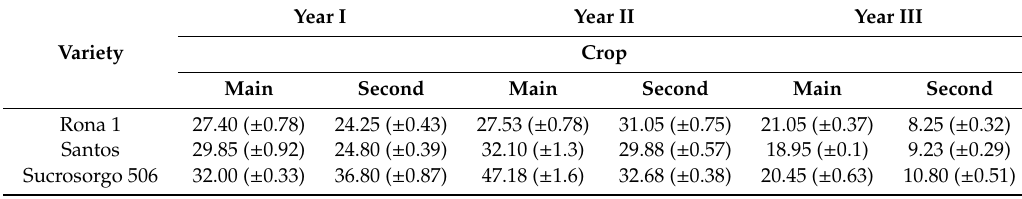
Table 1. Descriptive statistics (mean, standard error) for straw dry matter yield of sorghum (Mg · ha − 1 ).